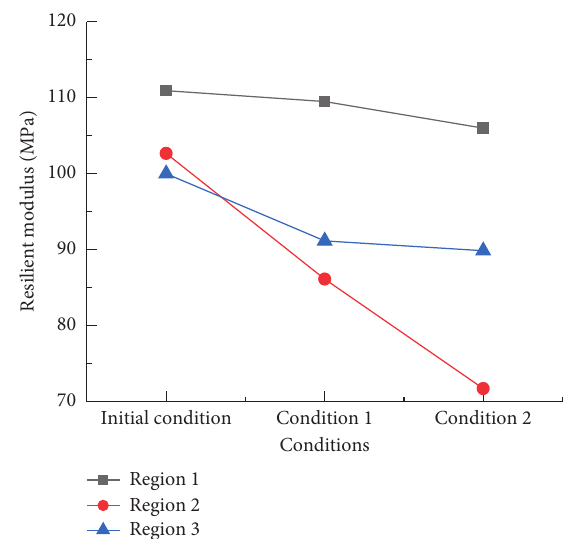
Figure 16: The change of resilient modulus in different regions under different